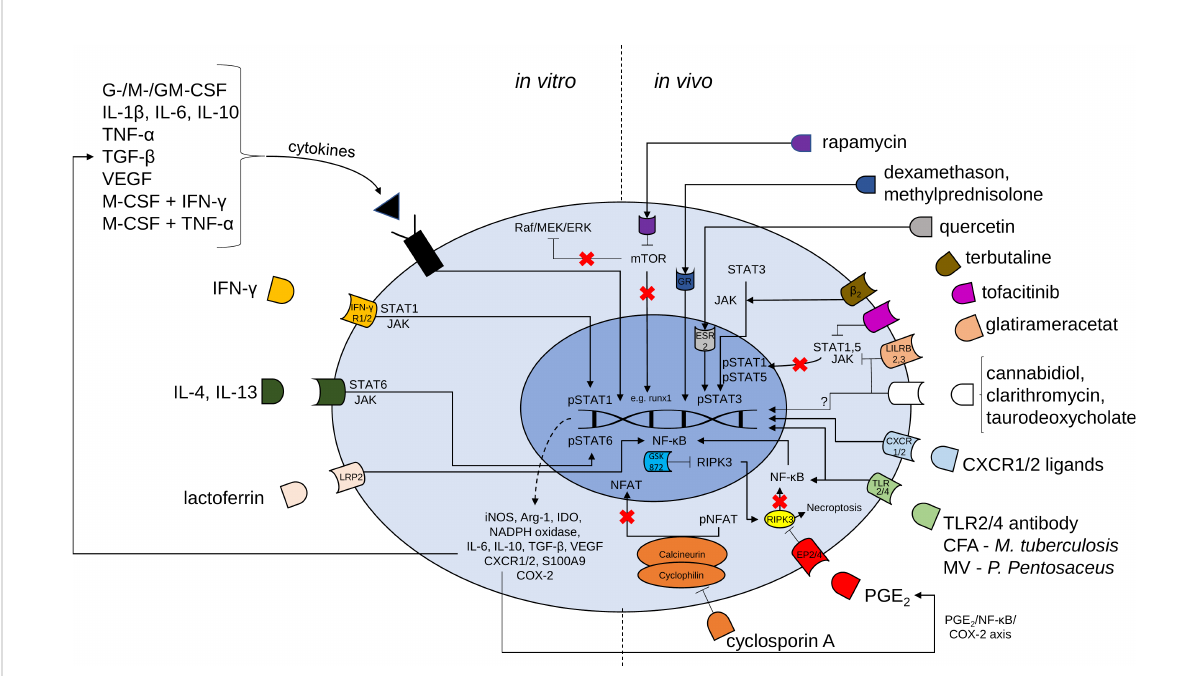
FIGURE 1 Mechanisms of possible pharmacological targets for the induction of MDSCs. Proliferation and activation of MDSCs is regulated by transcription factors such as signal transducer and activator of transcription (STAT) 3, STAT1, STAT5, STAT6 and nuclear factor kappa-light-chain-enhancer of activated B cells (NF- k B). In vitro generation of MDSCs is induced by a large variety of cytokines and cytokine combinations and lactoferrin. MDSC generation may be followed by adoptive transfer cell therapy to induce the bene fi cial effects of MDSCs. Various compounds [e.g. rapamycin, glucocorticoids, terbutaline, tofacitinib, glatirameracetat, cannabidiol, clarithromycin, taurodeoxycholate, CXCR1 or CXCR2 ligands, complete Freund ’ s adjuvant (CFA), membrane vesicles (MV), Toll-like receptor (TLR) 2/4 agonistic antibodies, prostaglandin E 2 , cyclosporine A and receptor interacting protein kinase (RIPK) 3 inhibitor (GSK 872)] may be used for accumulation of MDSCs in vivo . G-CSF granulocyte colony-stimulating factor, M-CSF macrophage CSF, GM-CSF granulocyte-macrophage CSF, IL Interleukin, TNF tumor necrosis factor, TGF transforming growth factor, VEGF vascular endothelial growth factor, IFN interferon, mTOR mammalian target of rapamycin, JAK Janus kinase, LRP lactoferrin receptor, iNOS inducible nitric oxide synthase, Arg arginase, IDO indoleamine 2,3-dioxygenase, NADPH nicotiamide adenine dinucleotide phosphate, NFAT nuclear factor of activated t cells, p phosphorylated, CXCR CXC chemokine receptors, COX